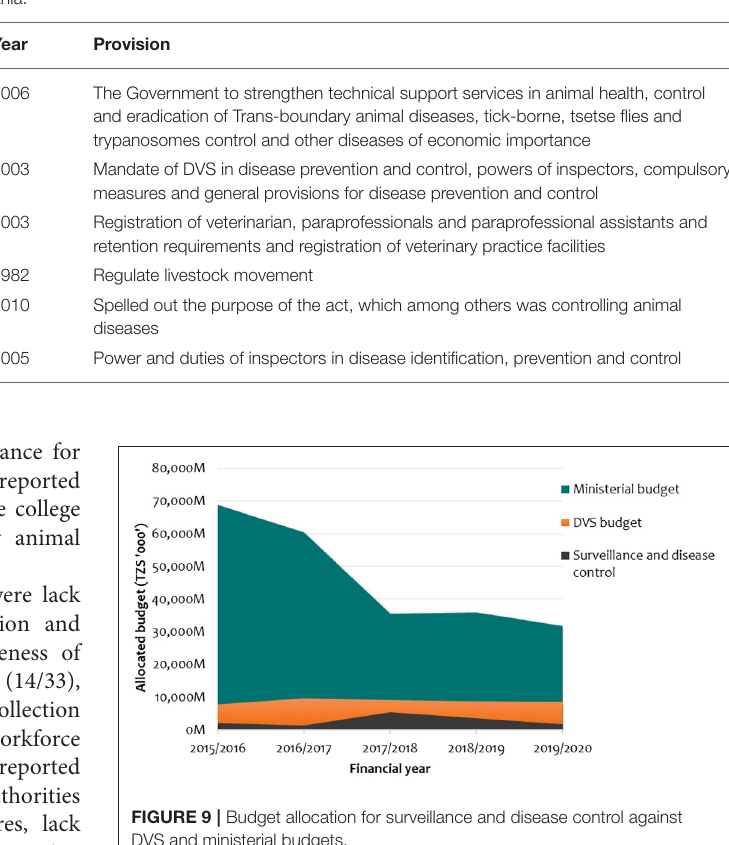
TABLE 6 | Legal documents guiding animal health surveillance in Tanzania.